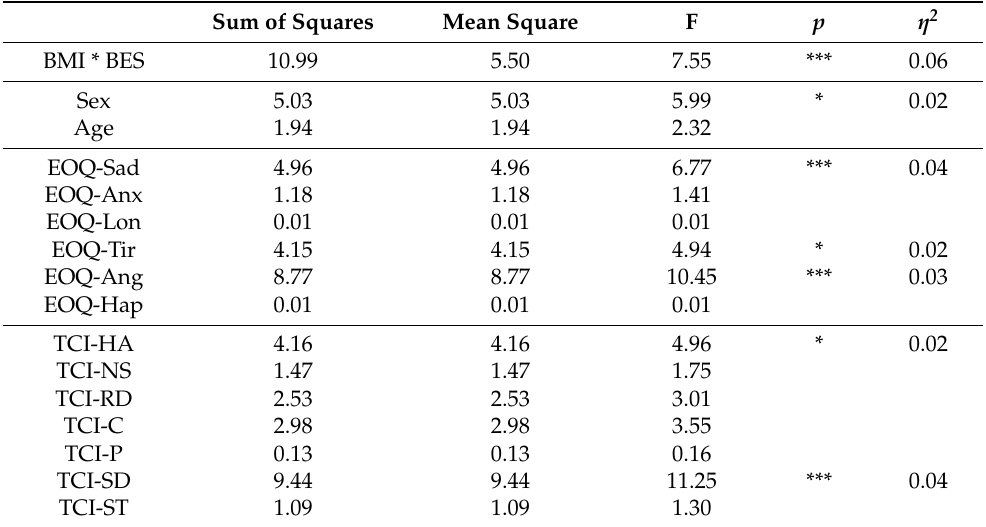
Table 4. Analysis of covariance. Sum of